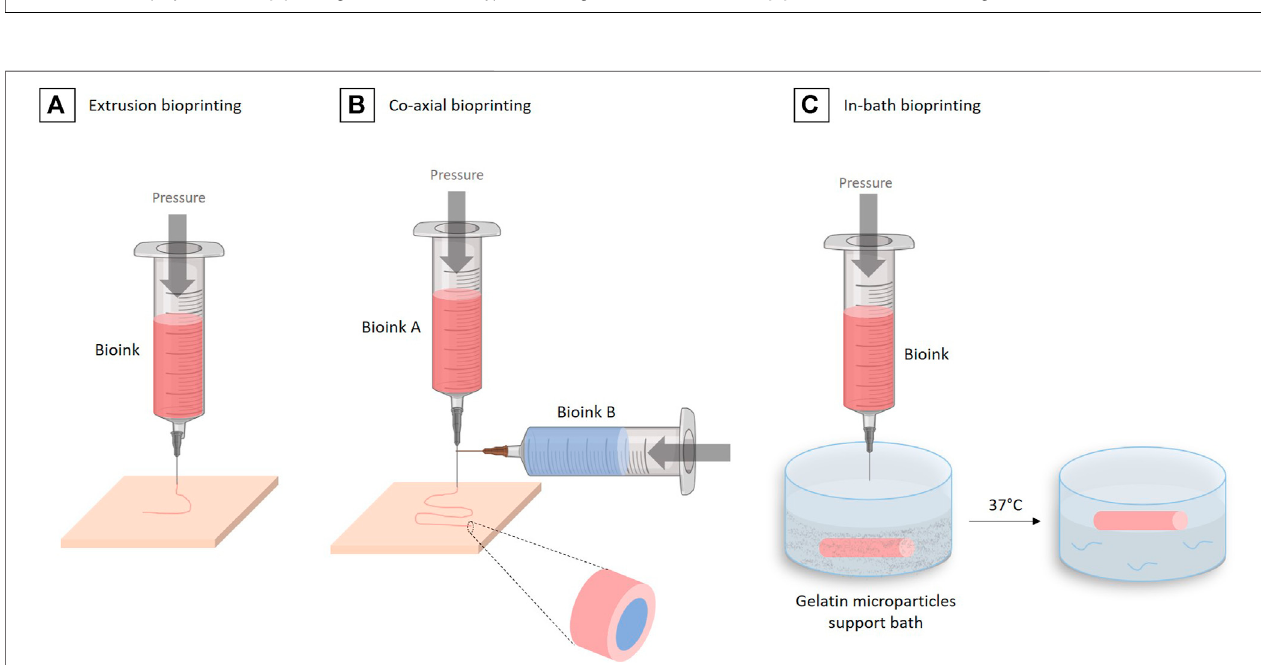
FIGURE 7 | The different 3D bioprinting techniques for vascular tissue engineering. (A) Extrusion bioprinting. (B) Co-axial bioprinting. (C) In-bath bioprinting.